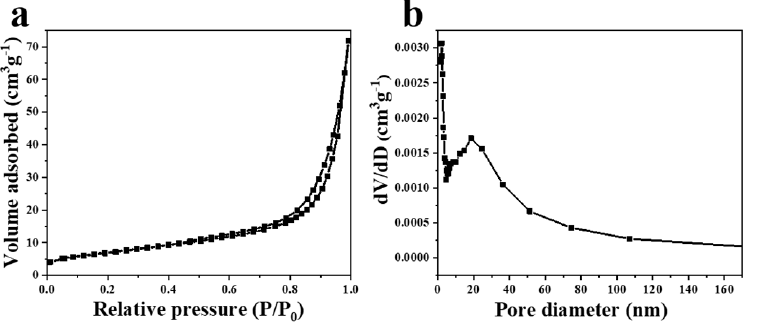
Figure 7. ( a ) N 2 adsorption-desorption isotherm of the GO/ZnO nanosheet composites, ( b ) the corresponding pore size distribution.